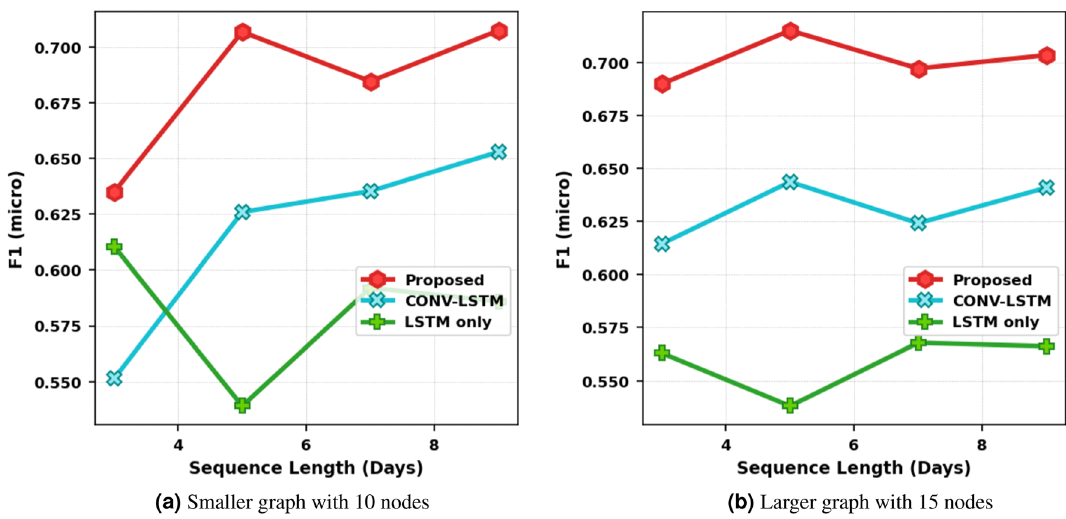
Figure 3. Impact of temporal memory on stress